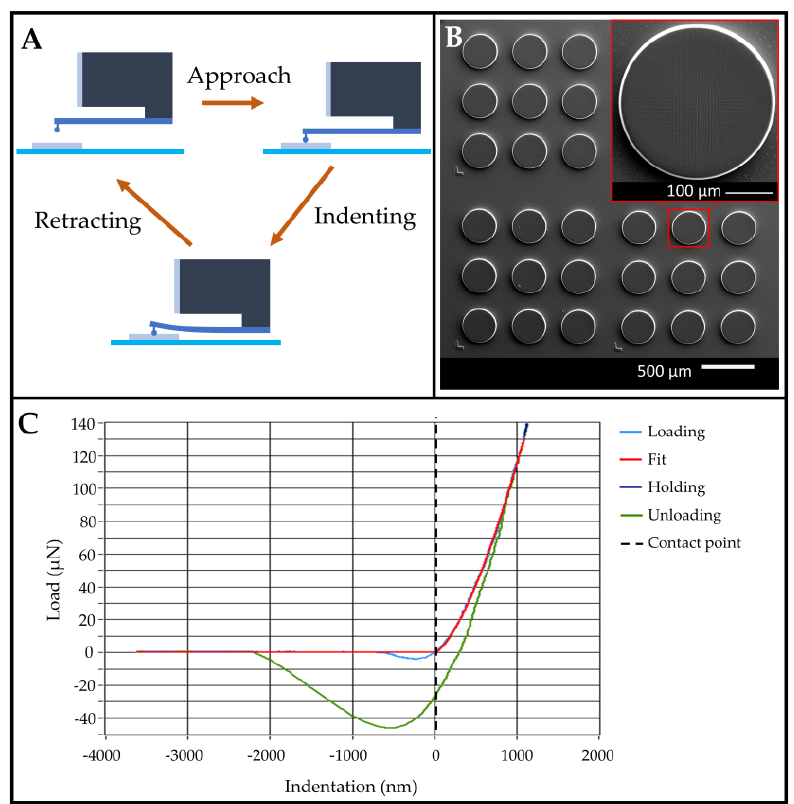
Figure 1. Indentation experiments. ( A ) Schematic indentation procedure with an interferometer- based nanoindenter (Piuma, Optics 11). ( B ) SEM micrograph of three sets of pedestal arrays employed for the indentation experiment. Each set consists of nine replicates, with the inset showing a detailed view of one pedestal. ( C ) Typical load/indentation plot with Hertzian fit. The contact point is located at an indentation depth of zero. Before the contact point, a snap-in occurs, and probe/IP-PDMS adhesion is visible in the unloading curve.